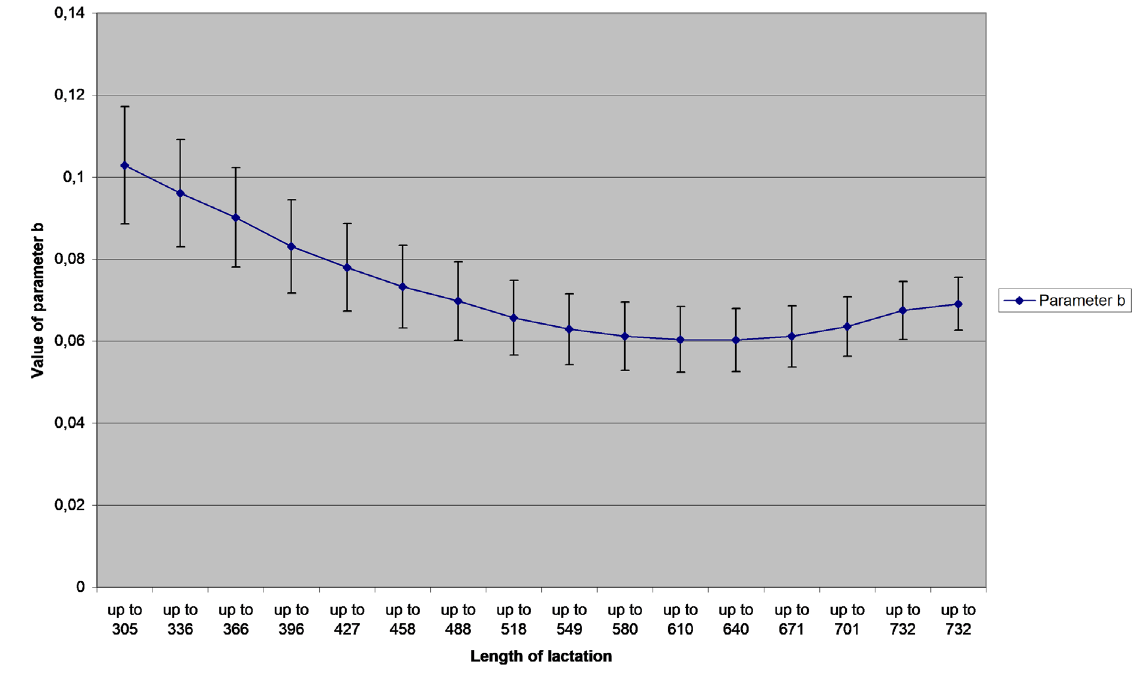
Figure 2. Mean values and their standard errors (+/– 2.96 standard error) of the assessed parameter b of Wood’s model for different lengths of lactation (in days).